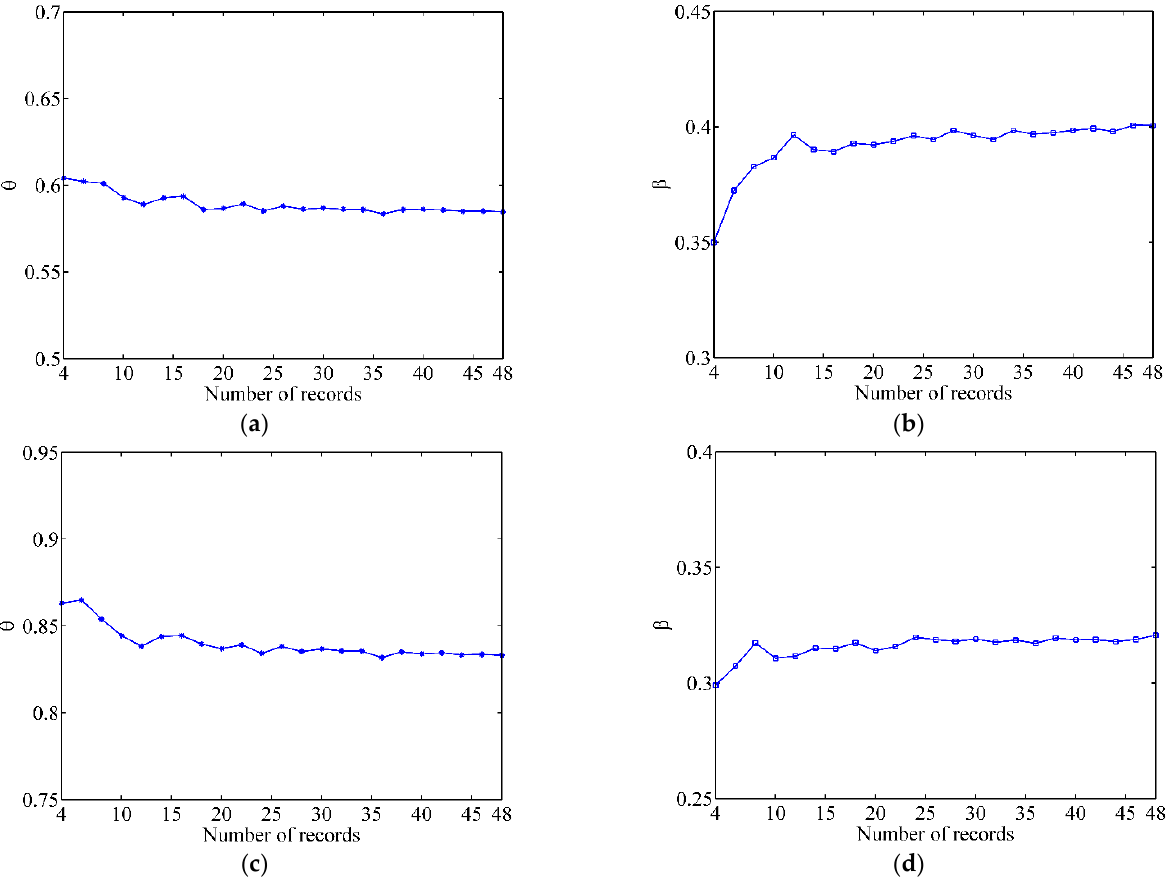
Figure 9. The estimated θ and β versus number of records: ( a , b ) for parked condition, and ( c , d ) for normal operation condition.